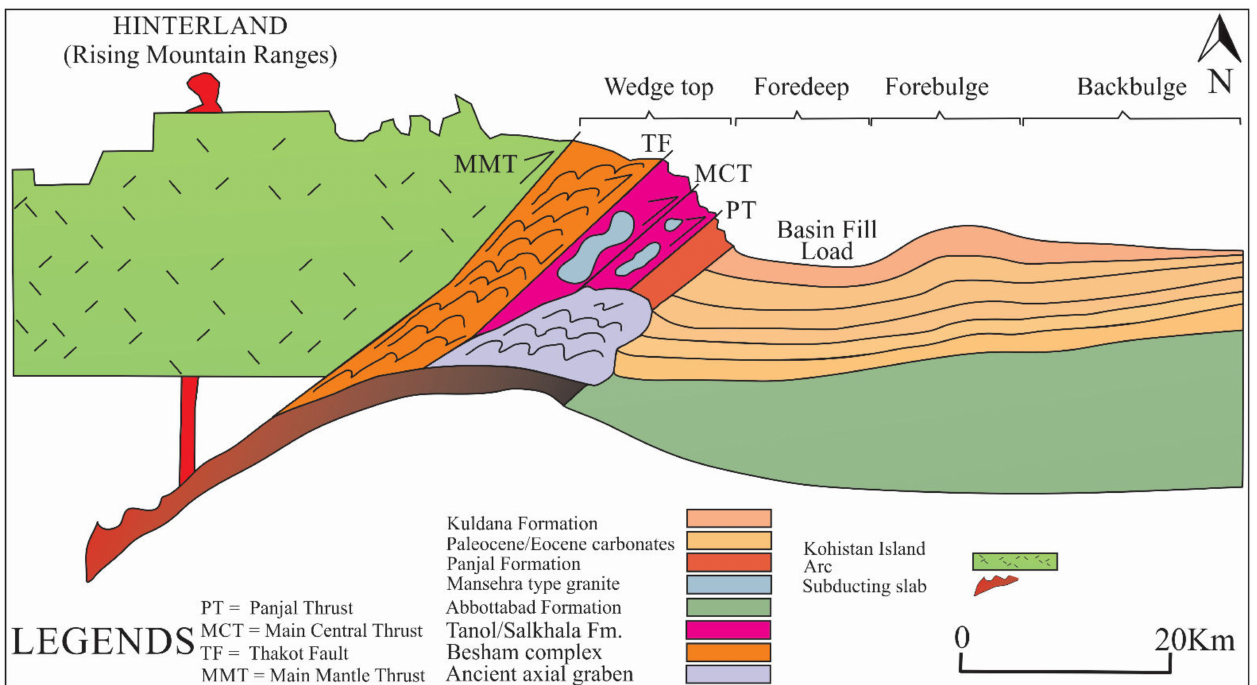
Figure 15. Hypothetical model of Indo-Eurasian continental-continental collision followed by the development of the Himalayan-Foreland Basin and the deposition of the Kuldana